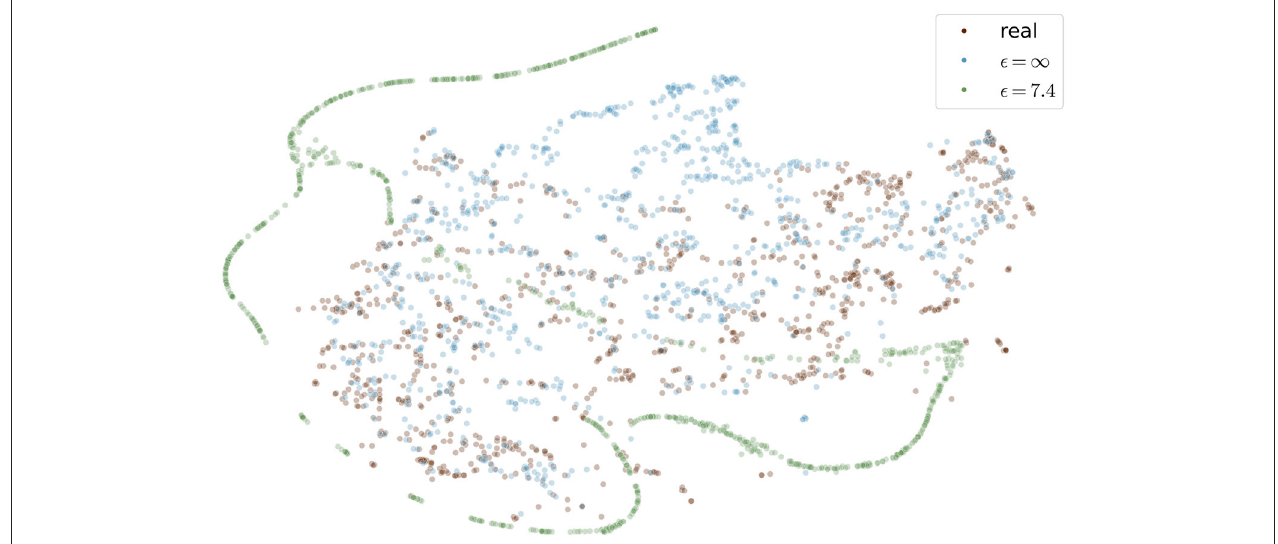
FIGURE 9 | Visualization of real and generated images with and without differential privacy in a t-SNE embedding. Each point represents an image. The distribution of real images and generated images without privacy almost entirely overlap. In contrast, the images with privacy guarantees are only partially overlapping and cluster at the edges, distant from the real images. The embedding showing the specific image instead of a point can be found in the Figure S1 in the supplementary